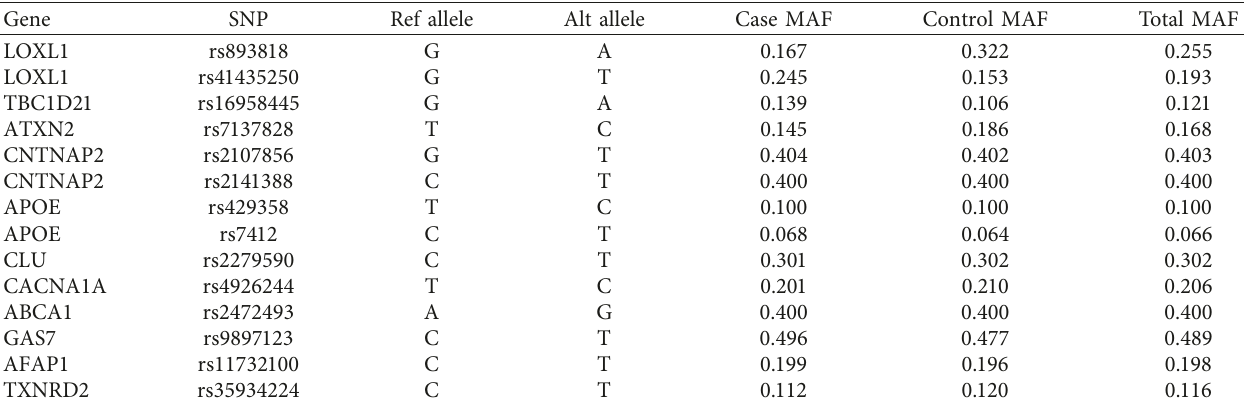
Table 5: MAFs of these SNPs.